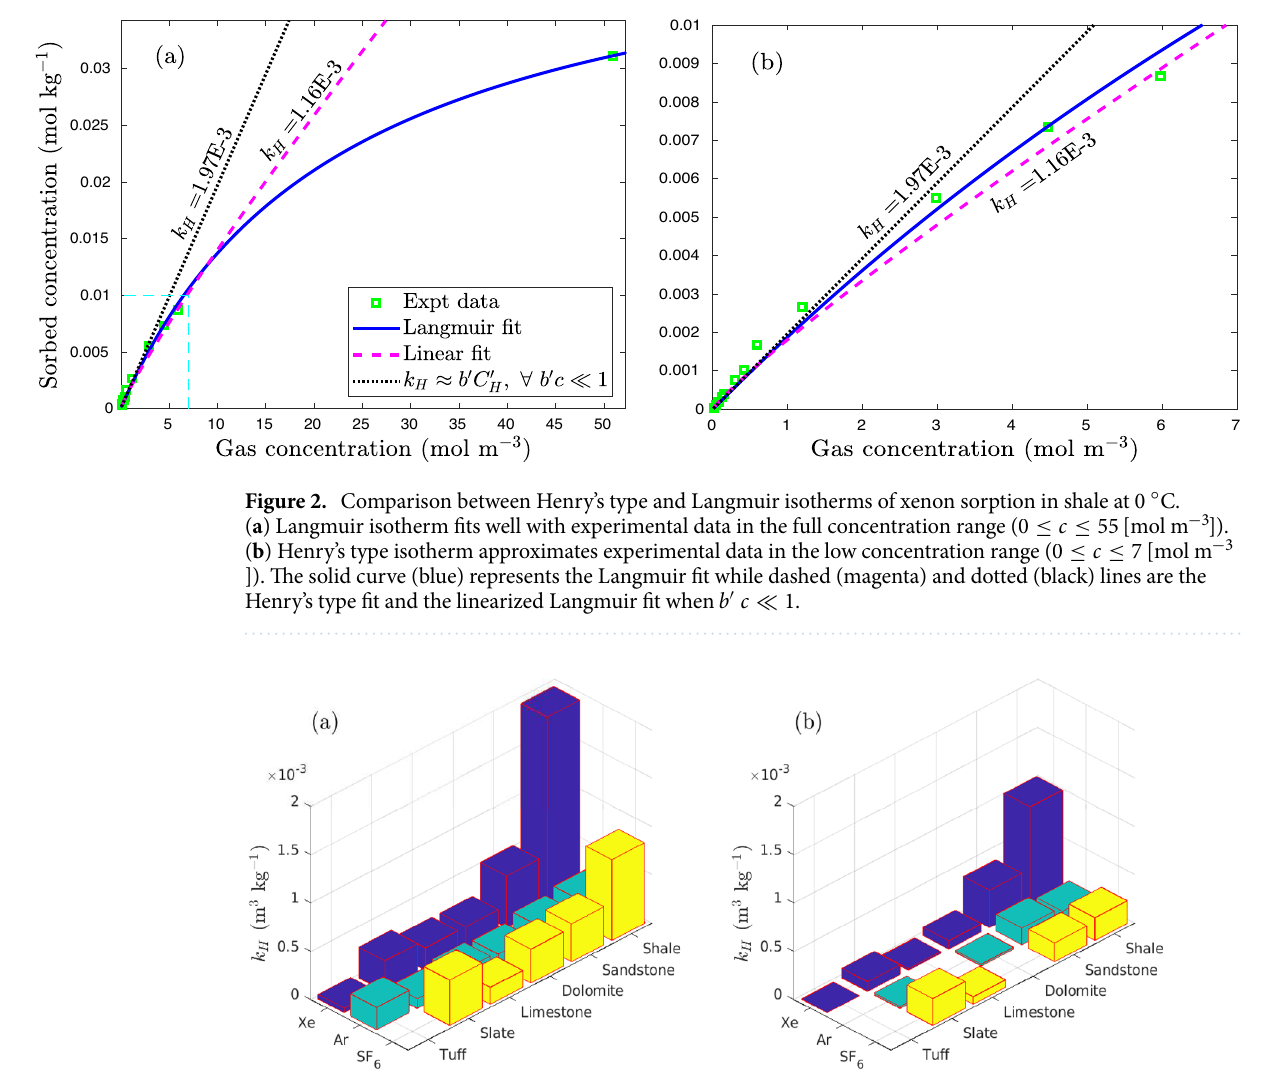
Figure 3. Equivalent Henry’s absorption constant of xenon, argon, and SF 6 in various geological materials at ( a ) 0 and ( b ) 20 ◦ C. Note that experimental data are unavailable for nonexistent